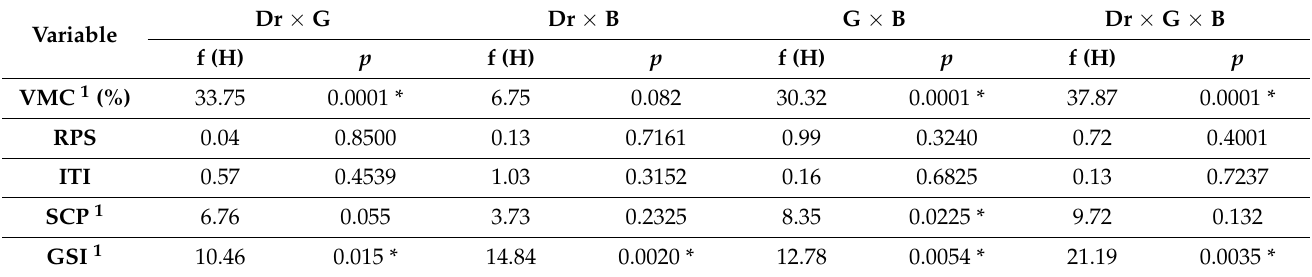
Table 3. f (H) and p -values of interactions between factors: drainage × geotextile, drainage × blocks, geotextile × blocks, and drainage × geotextile × blocks over the five variables (VMC, RPS, ITI, SCP, and GSI) ANOVA p < 0.05 statistic test f; 1 ANOVA for non-parametric variables: Kruskal–Wallis Test p < 0.05 statistic test H.